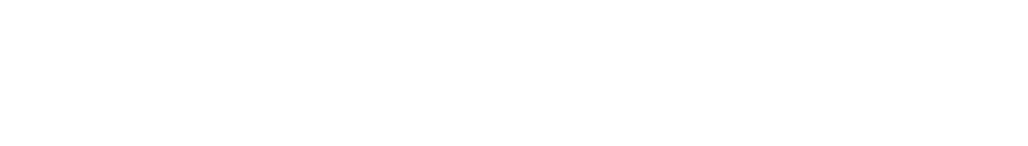
Logopediese Vereniging, Vol. 17, Nr. 1: Des.